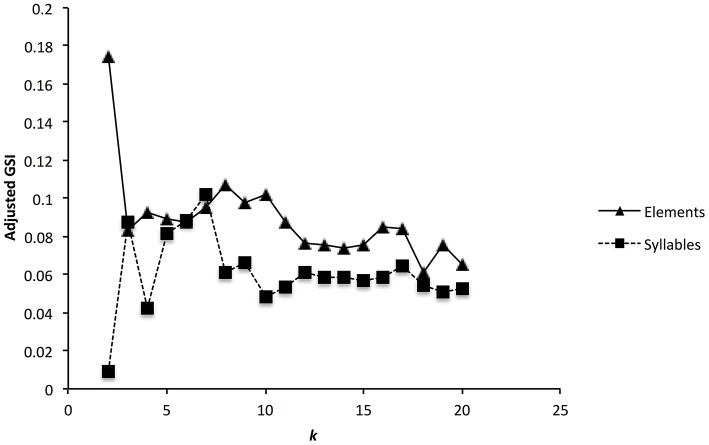
Cluster validation for zebra finch elements (a) and syllables (b). Graph shows the adjusted global silhouette index (GSI) for up to 20 different clusters. Peaks in the GSI correspond to clustering solutions with higher support.